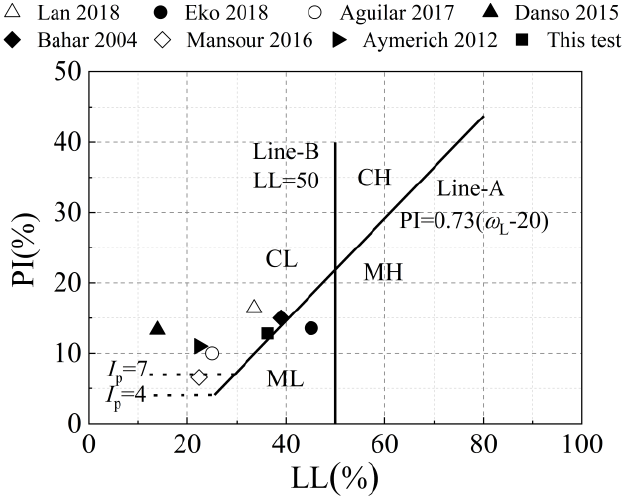
Figure 4. Soil plasticity diagram. (CL = low liquid limit clay; CH = high liquid limit clay; ML = low liquid limit powder soil; and MH = high liquid limit powder soil.) [1,14,19,23,26–28].